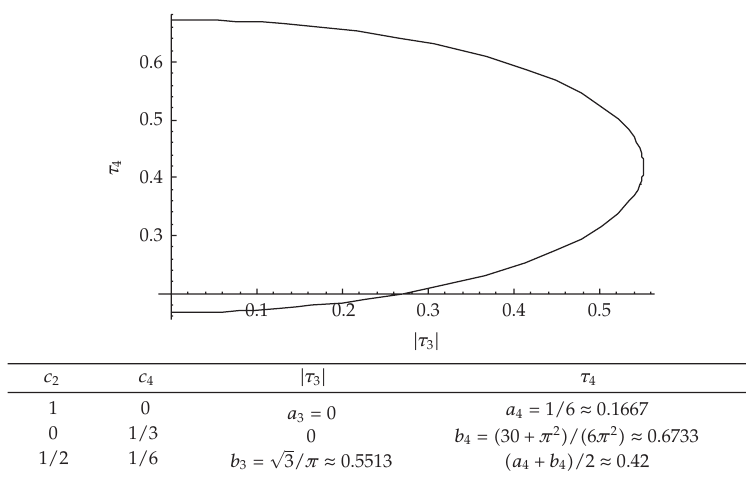
Figure 6: Boundary region and values of L- skew | τ 3 | and L- kurtosis τ 4 for third-order standard logistic power method pdfs. For asymmetric distributions, valid pdfs exist in the region inside the graphed boundary. For symmetric distributions, valid pdfs exist for τ 4 between a 4 < τ 4 < b 4 . The lower boundary point (cid:2)